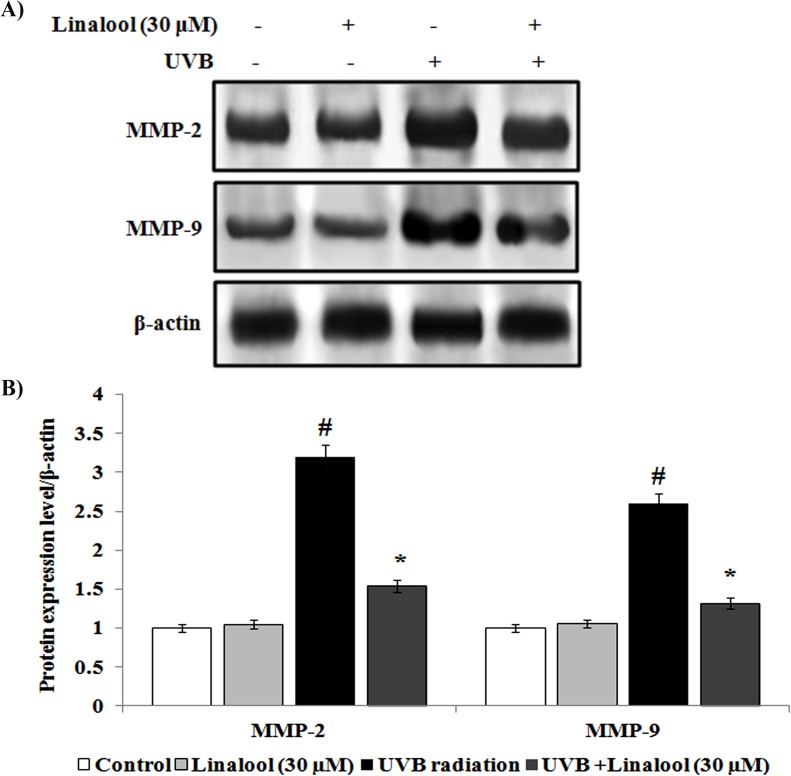
(A) Effect of linalool on UVB-induced expression of matrix metalloproteinases in HDFa. (B) The densitometry data represent means ± SD from three immunoblots and are shown as relative density of protein bands normalized to ß-actin level. Values not sharing a common marking (# and *) differ significantly at P < 0.05 (DMRT).